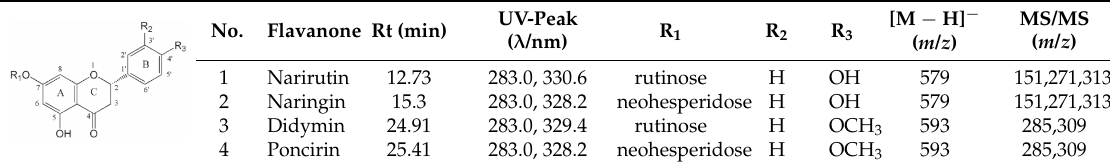
Table 1. Structural and chromatographic characteristics of four main flavanones in P. trifoliata extracts.